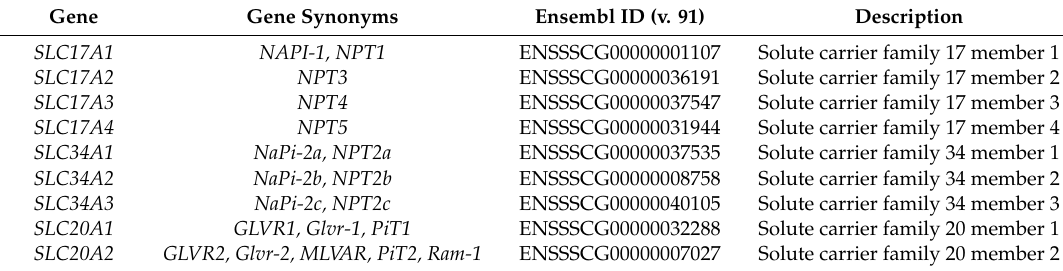
Table 1. Gene information of sodium / phosphate